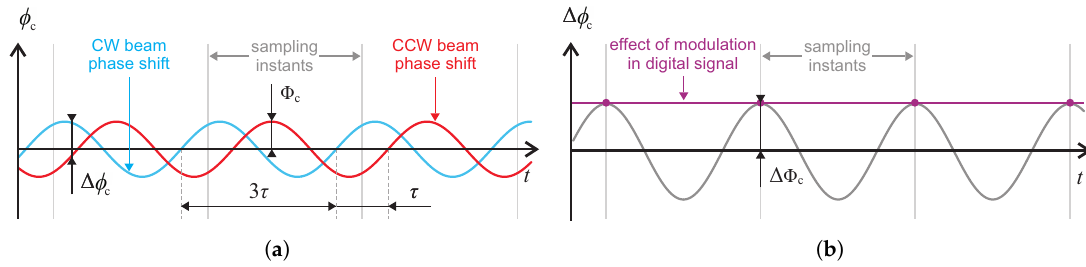
Figure 2. The proposed harmonic compensation modulation: the phase shift introduced to the CW and CCW beams ( a ), and their resulting phase difference ( b